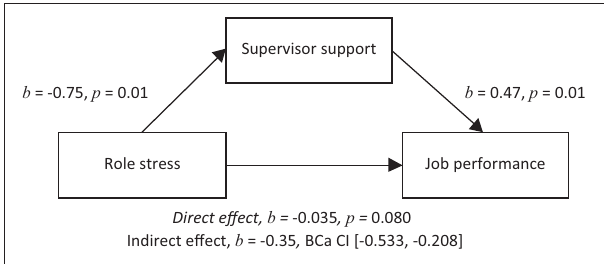
FIGURE 6: Diagram of the supervisor support mediation model with regression coefficients, indirect effects and bootstrapped confidence